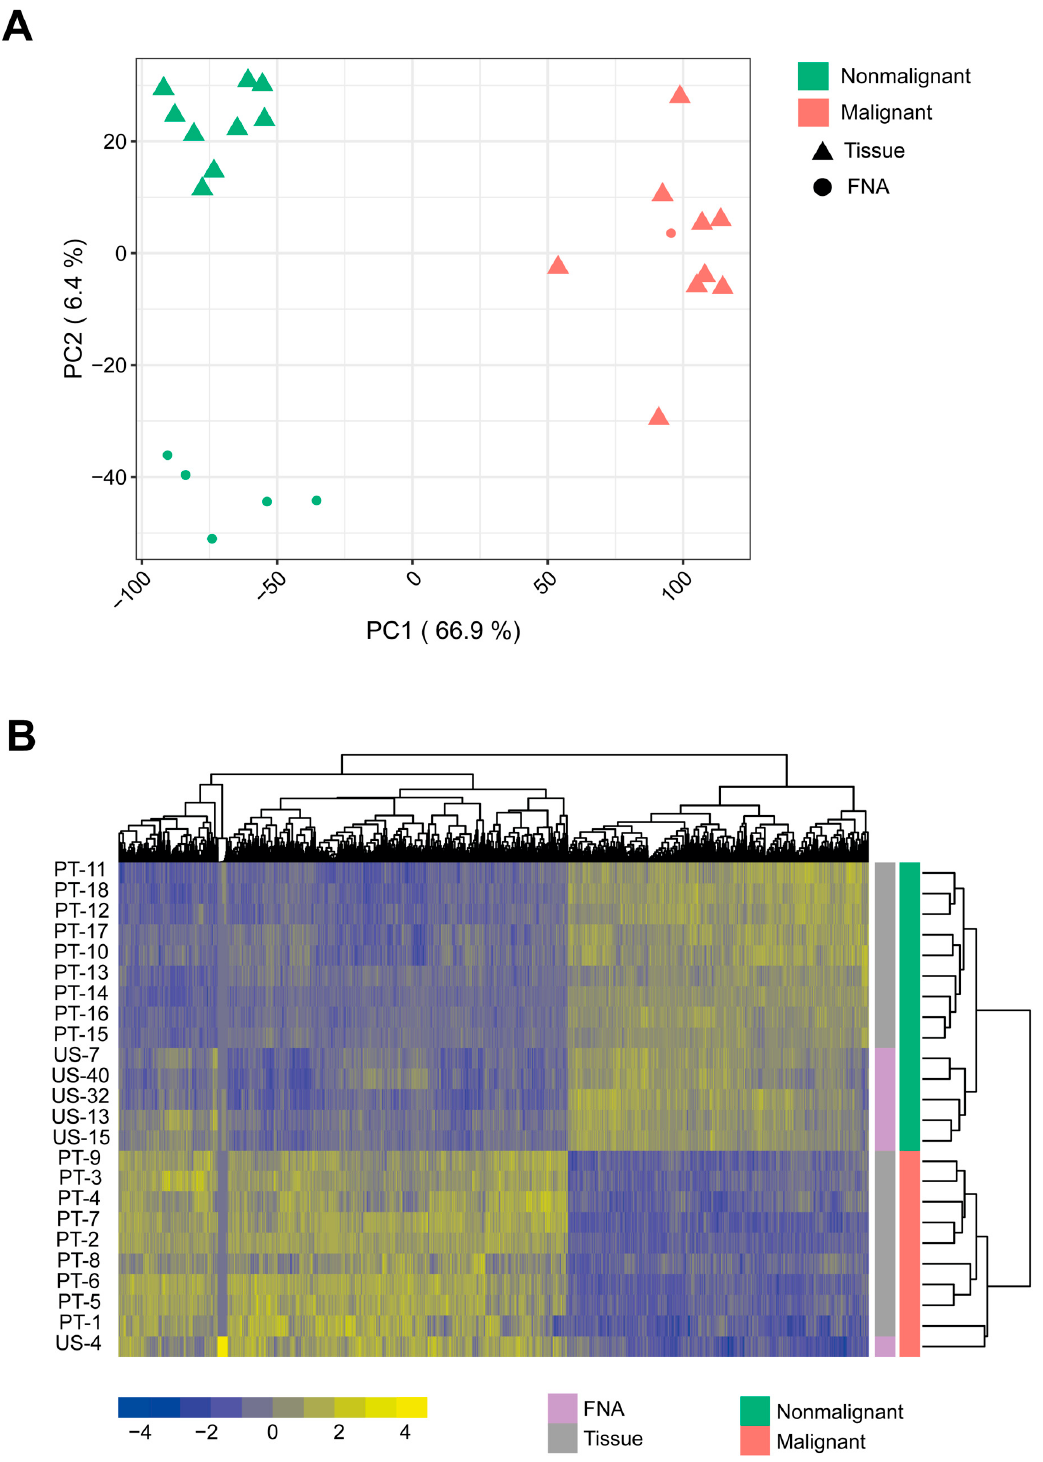
Figure 2. Differentially expressed genes (DEGs) between malignant and nonmalignant canine prostate samples. ( A ) Principal component analysis (PCA) based on the normalized regularized logarithm (rlog)-transformed read counts of the DEGs: fine-needle aspiration (FNA) samples (circle), prostate tissue samples (triangle), nonmalignant (green), malignant samples (red). PCA verified that most of the variance (66.9%, PC1) was associated with the altered expression between the malignant and the nonmalignant canine PCa samples; ( B ) Heatmap and hierarchical clustering of prostate tissue (gray), FNA (purple), nonmalignant (green) and malignant (red) samples and DEGs based on Euclidean distances between normalized rlog- transformed counts. Rows have been centered and scaled to compute